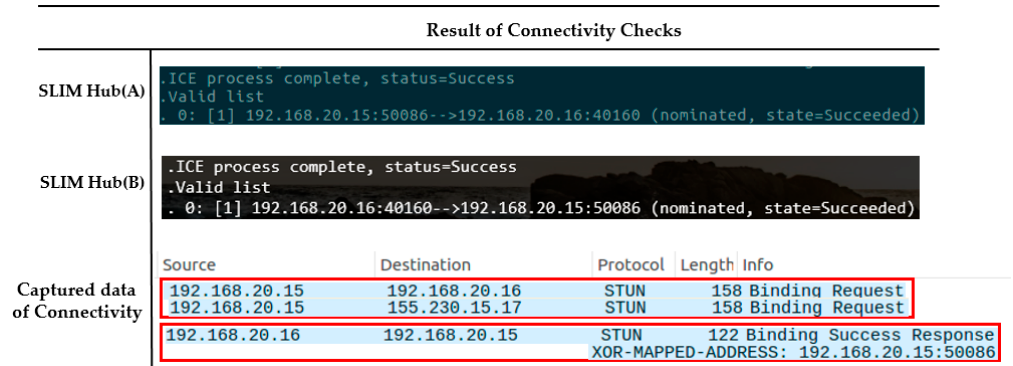
Figure 19. Connectivity environments of same NAT. ( a ) Configuration of experiment; ( b ) A list of SLIM hub’s ID and IP information. Figure 20. Connectivity checks in same private network. Figure 20. Connectivity checks in same private network.